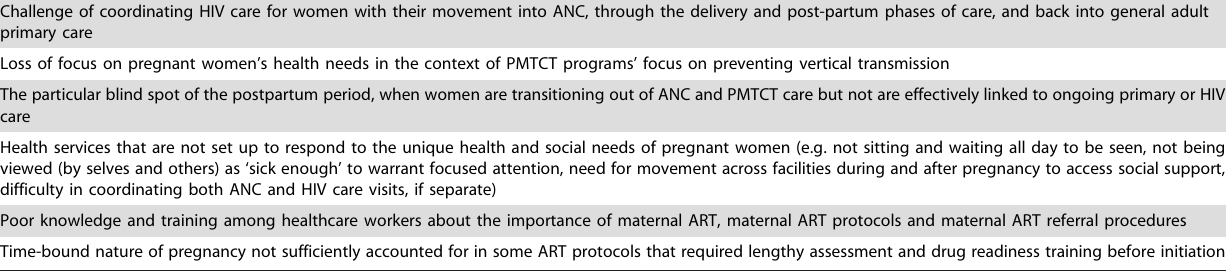
PREGNANCY-RELATED HEALTH SYSTEMS BARRIERS AND